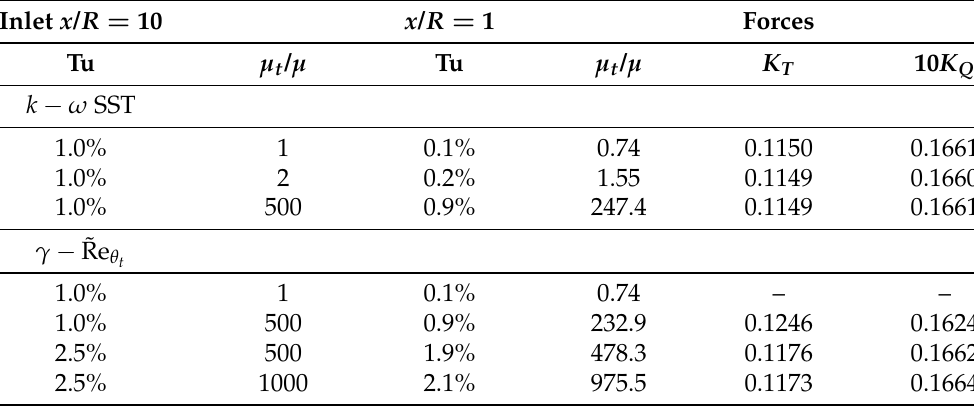
Table 6. Influence of the inlet turbulence quantities on the propeller forces at Re = 1 × 10 6 for J = 0.568. Turbulence intensity at x / R = 1 refers to section r / R = 0.7. Inlet x / R = 10 x / R = 1